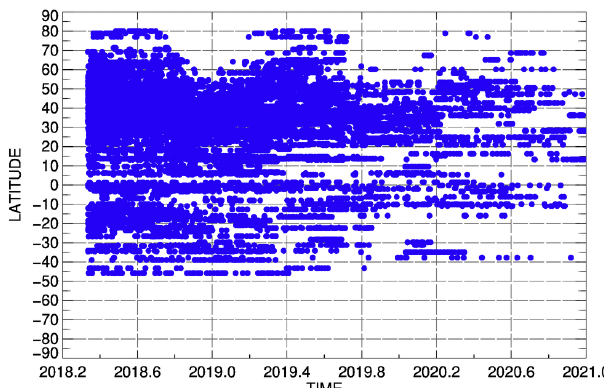
Figure 5. Spatial and temporal representation of the co-location data used for the validation with ground-based measurements for the time period of the TROPOMI/S5P TCWV data availability (May 2018 to December 2020).